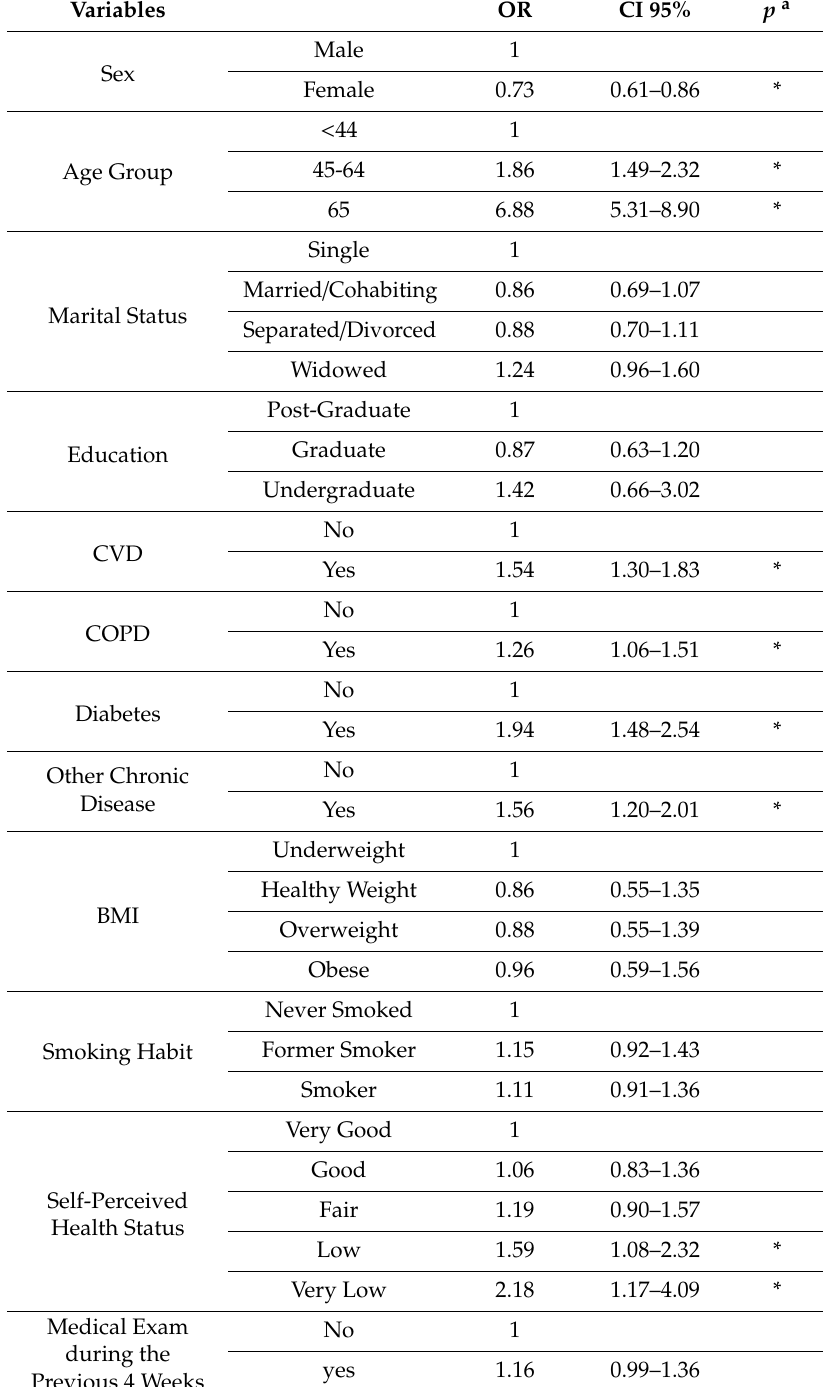
Table 2. Variables associated with HCWS’s vaccine coverage during the previous 12 months results of multilevel